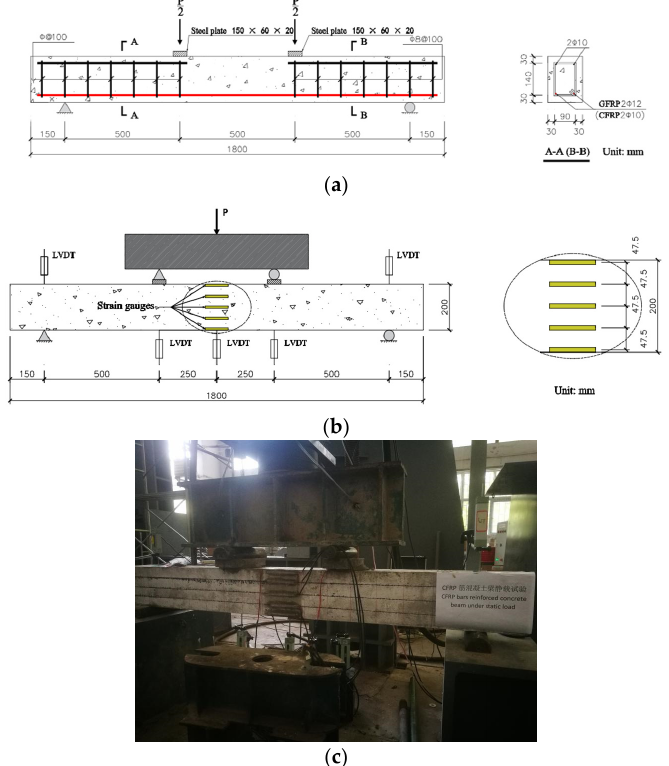
Figure 1. Specimen and test setup: ( a ) specimen size and reinforcement (note: 30 mm concrete cover for top, bottom, and side); ( b ) schematic diagram; ( c ) photograph.